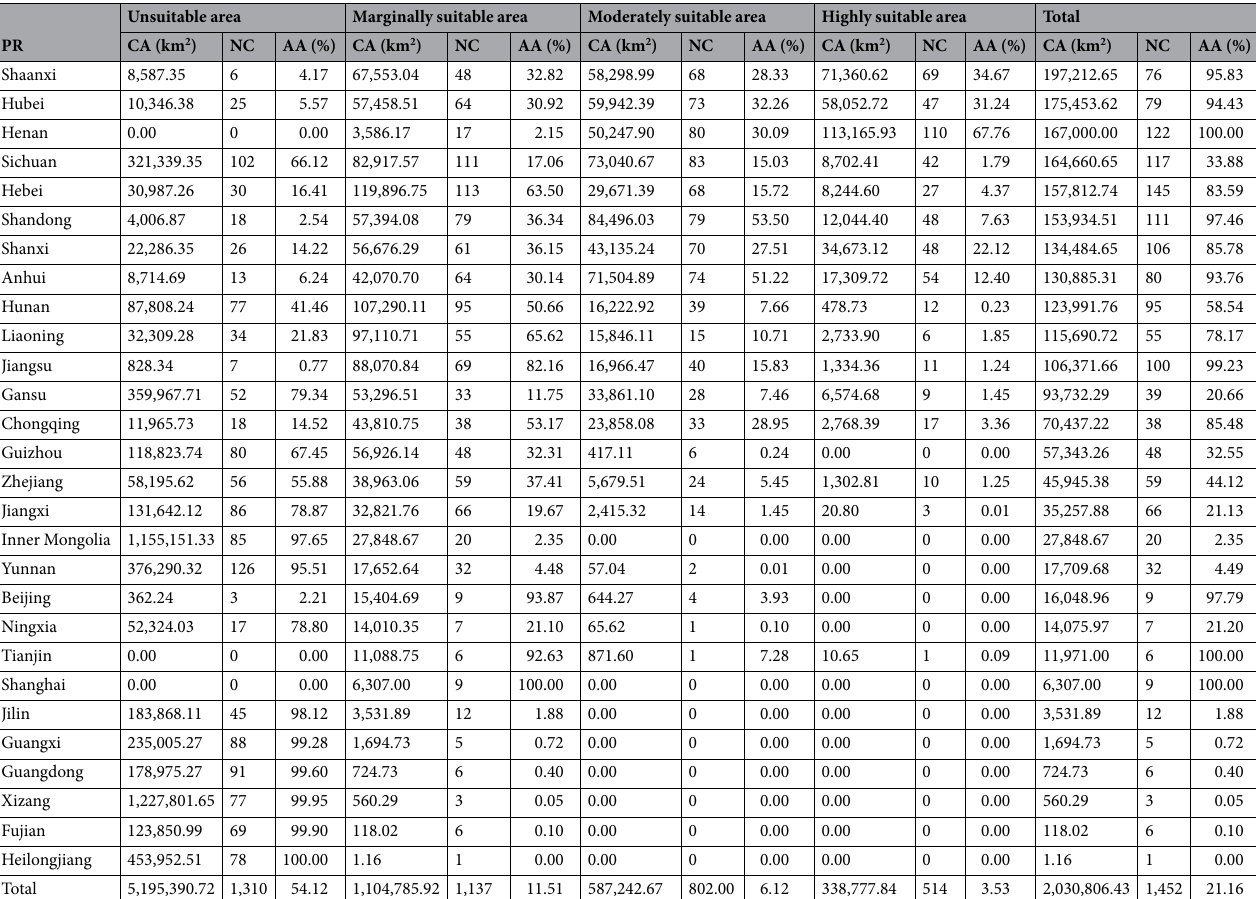
Table 2. Portions of different classes of potential distribution area of P . ostii under current climatic and geological conditions. Notes: PR = province (region); NC = number of cities/counties; CA = coverage area; AA = accounted area for area of